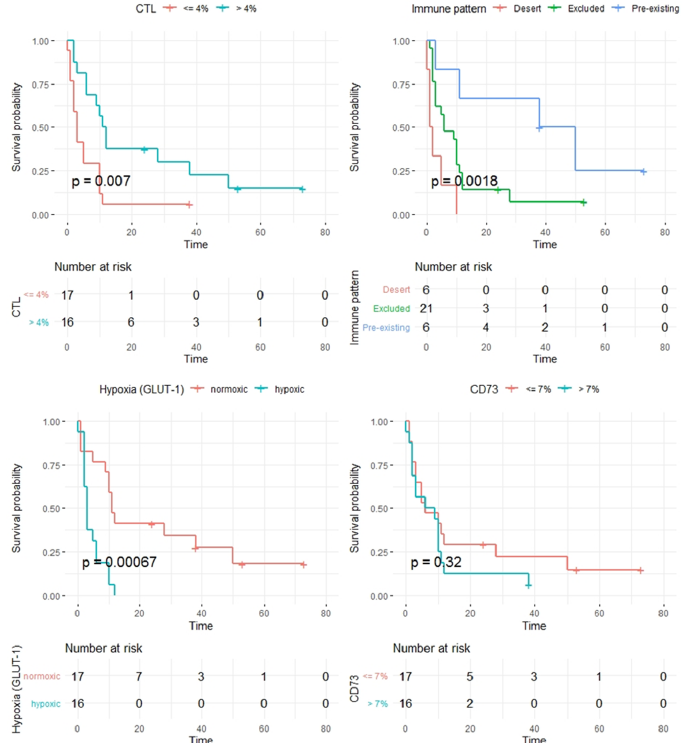
Figure 3. Kaplan–Meier plots for CD8+ CTL (upper left), immune phenotypes (upper right), GLUT-1 high positive tumor cells (bottom left), and CD73 positive tumor cells (bottom right).